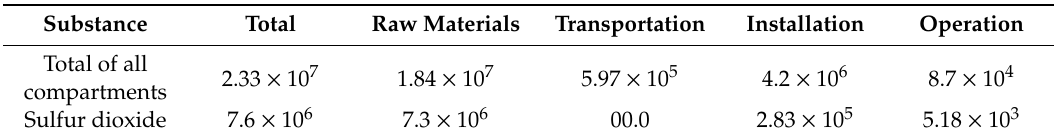
Table 10. Analyzing ‘TWF-Phases’; Method: TRACI / Characterization / Carcinogenic Category / Sulfur Dioxide (SO 2 ), Unit kg (H + moles eq ).